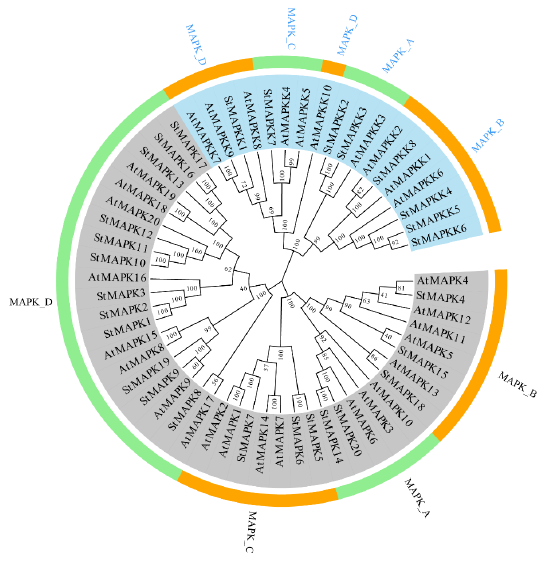
Figure 2. Phylogenetic relationships between Arabidopsis and potato MAPK and MAPKK family members.